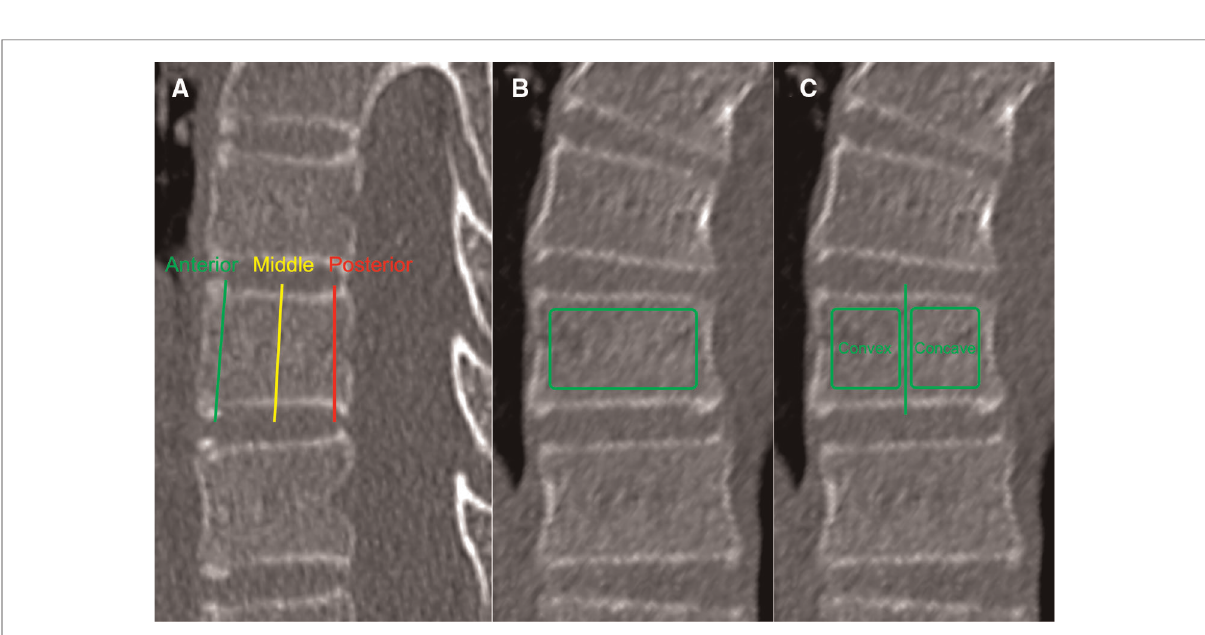
FIGURE 2 Schematic diagram of VB-HU measurement; three measurement locations were set on the sagittal plane ( A ): immediately posterior to the anterior vertebral cortex, in the middle of the vertebral body, and immediately anterior to the posterior vertebral cortex. The VB-HU of the whole vertebra ( B ) and the VB-HU within concave and convex sides ( C ) were obtained on the coronal